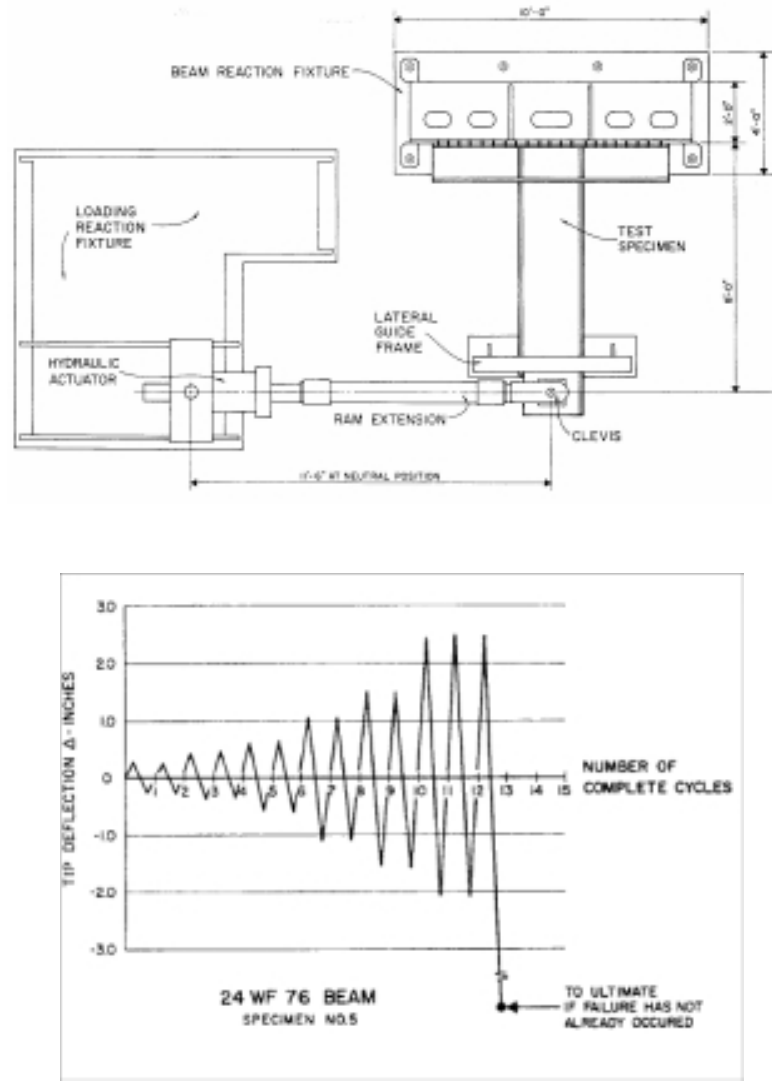
Fig. 15. Test arrangement and typical load history.